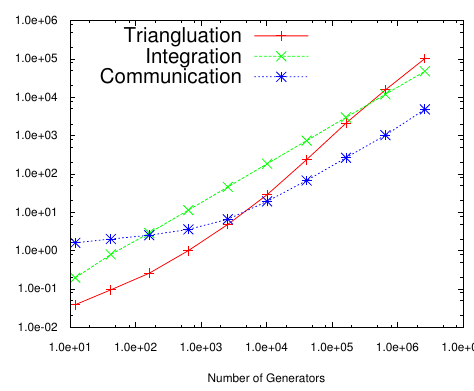
Fig. 7. Timings for various portions of MPI-SCVT using 2 pro- cessors and 2 regions. As the problem size increases the slope for both triangulation (red-solid) and integration (green-dashed) remain roughly constant.